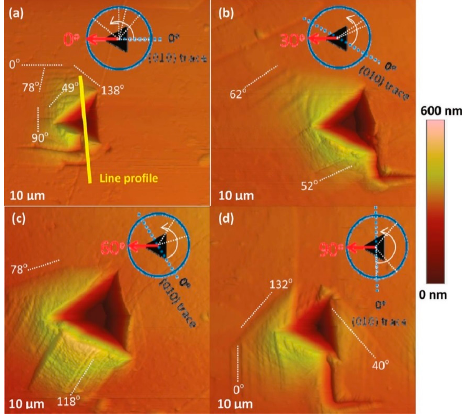
Figure 19. AFM images of residual indents on the (001) face of succinic acid, with the (010) traces being the reference. (Reproduced with permission from American Chemical Society, Reference 109).